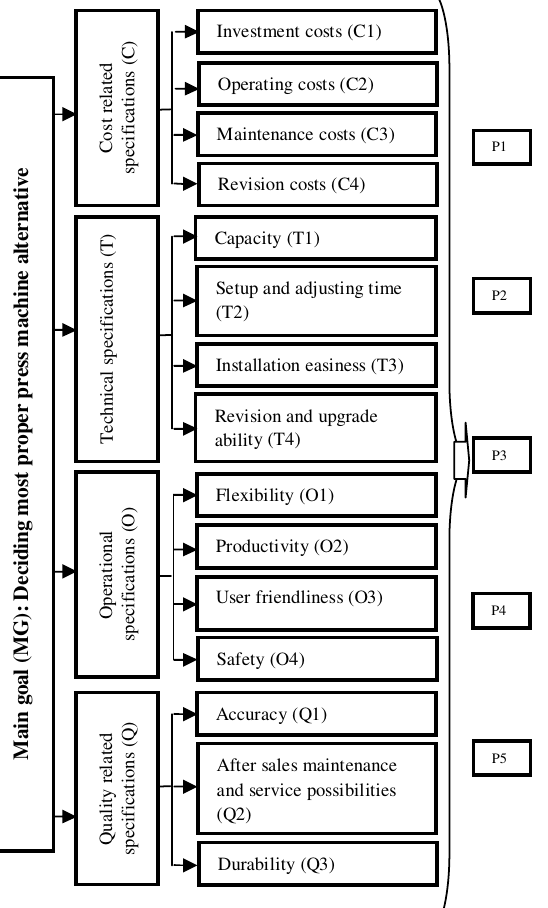
Figure 5. Decision criteria for machine tool selection process After criteria determination phase via modified DELPHI method, criteria weights are determined via fuzzy AHP